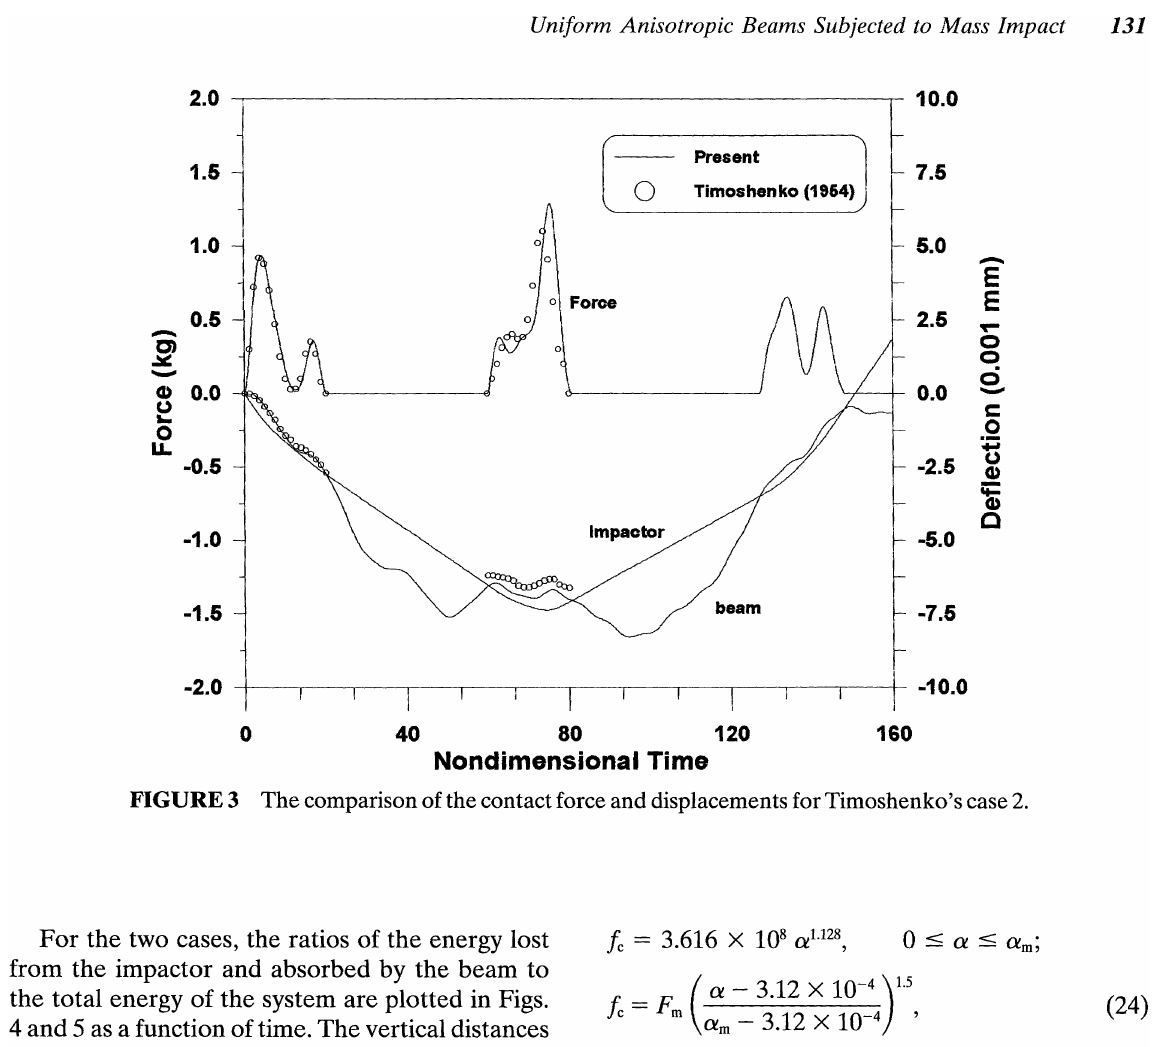
FIGURE 3 The comparison of the contact force and displacements for Timoshenko's case